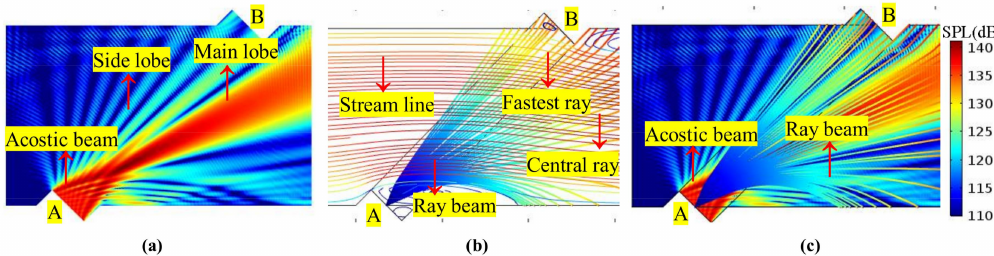
Figure 7. Relations among the acoustic beam, ray beam, central ray, and fastest ray in the flow field ( v = 50 m/s, PR profile, downstream). ( a ) Acoustic beam. ( b ) Ray beam and streamline. ( c ) Ray beam and acoustic